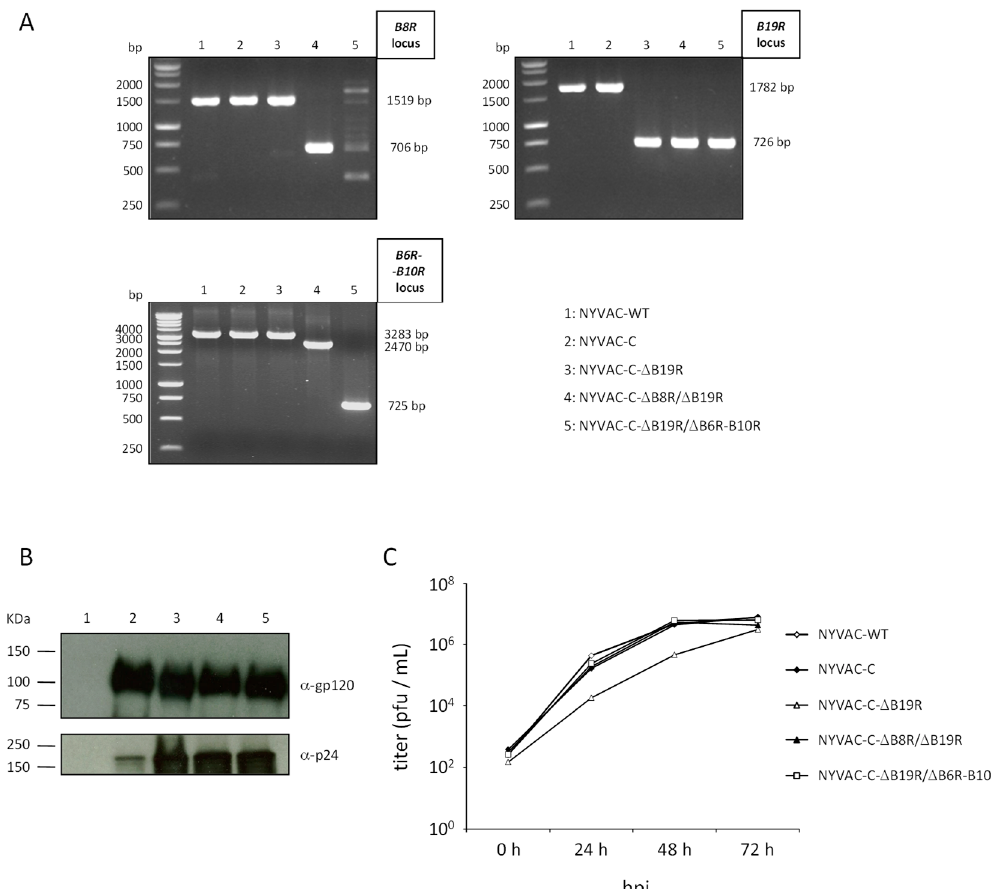
Figure 2. In vitro characterization of NYVAC-C mutants with deletion of genes involved in interferon (IFN) and cytokine signalling inhibition. ( A ) Confirmation of B8R , B19R and B6R-B10R gene deletion by PCR analysis. Viral DNA was extracted from BSC-40 cells infected as in Figure 1A. Primers spanning gene flanking sequences were used for PCR analysis of B8R , B19R and B6R-B10R loci. Sizes for parental NYVAC and deletion mutants are indicated. ( B ) Western blot showing HIV antigen expression. BSC-40 cells were infected as in Figure 1A. At 24 h post-infection, cells were lysed and cell extracts fractionated and analysed as in Figure 1B. ( C ) Analysis of virus growth in CEF cells. CEF cell monolayers were infected with NYVAC-WT, NYVAC-C or NYVAC-C deletion mutants (0.01 pfu/cell). At various times post-infection (0, 24, 48. and 72 h), cells were collected and infectious viruses quantified by immunostaining plaque assay in BSC-40 cells.